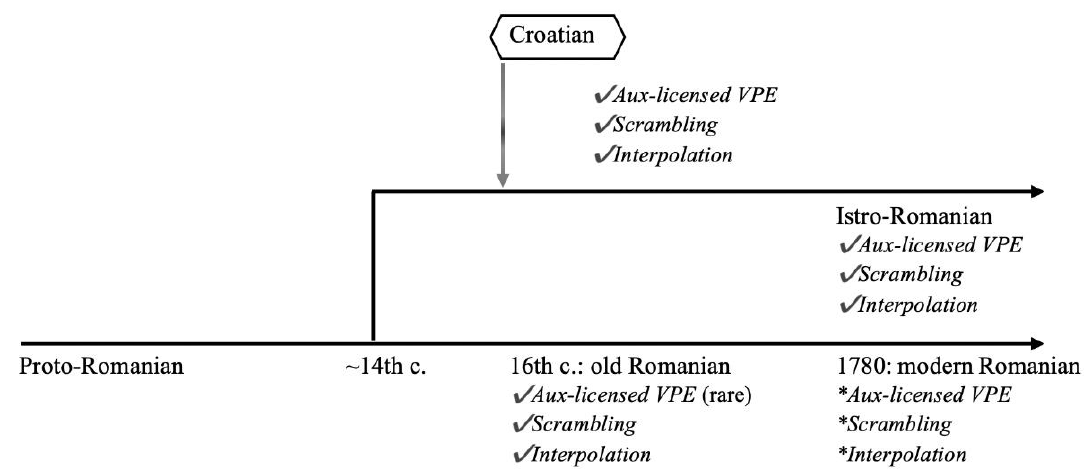
Figure 1. The relation between Istro-Romanian, old Romanian, and Croatian.